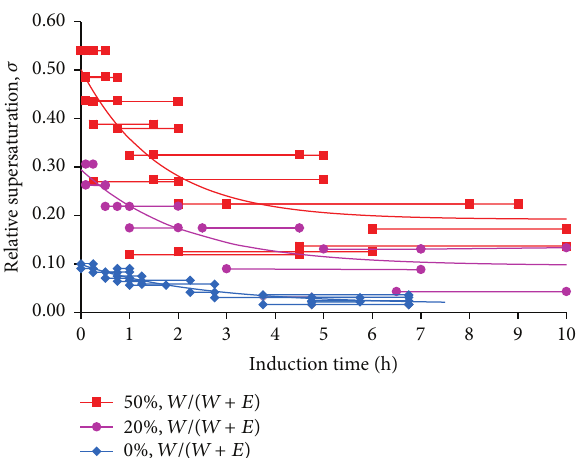
Figure 5: SNT in water-ethanol mixtures at 10 ∘ C for three different water concentrations. A best-fit exponential curve is drawn for each concentration.